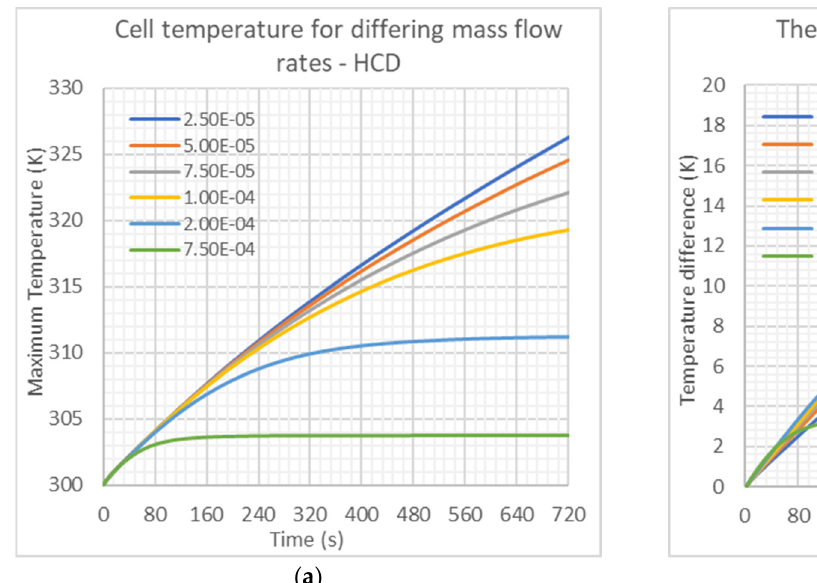
Figure 12. HCD–effects of mass flow rate on: ( a ) Maximum cell temperature; ( b ) Cell temperature difference.